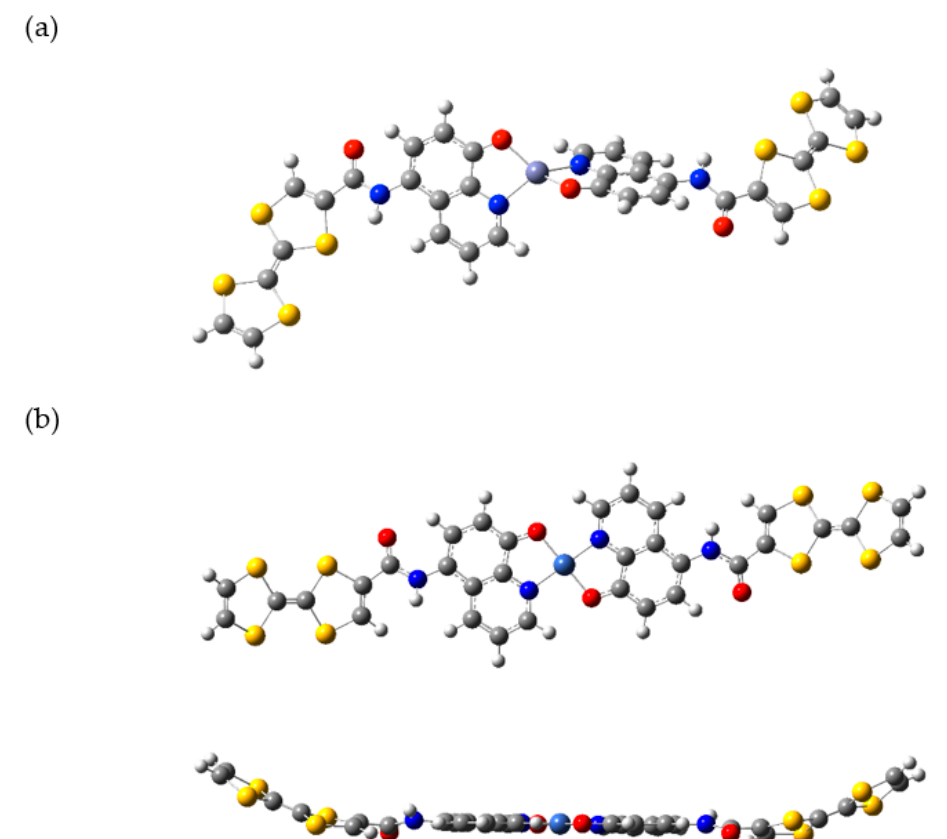
Figure 2. Optimized molecular structures of ( a ) Zn complex 1 and ( b ) Ni complex 2 in their isolated states on the basis of DFT method (B3LYP/LANL2DZ for transition metals and B3LYP/6–31G(d,p) for the other atoms).